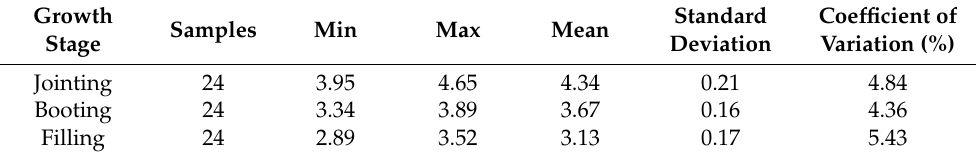
Table 3. Descriptive statistics for the rice leaf nitrogen content (LNC) at different growth stages.